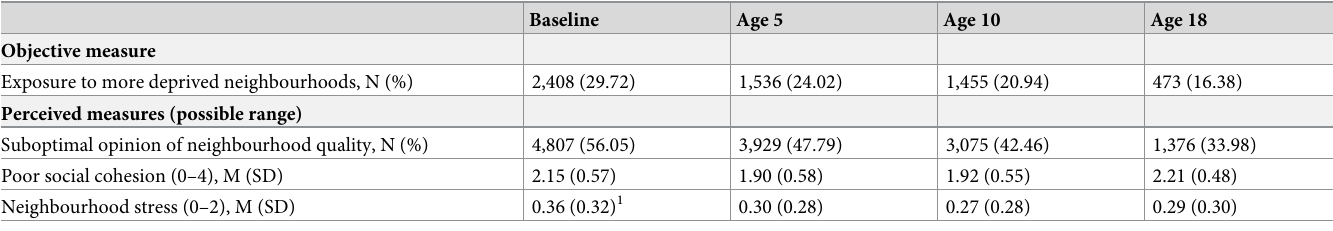
Table 3. Summary of perceived and objective neighbourhood measures.